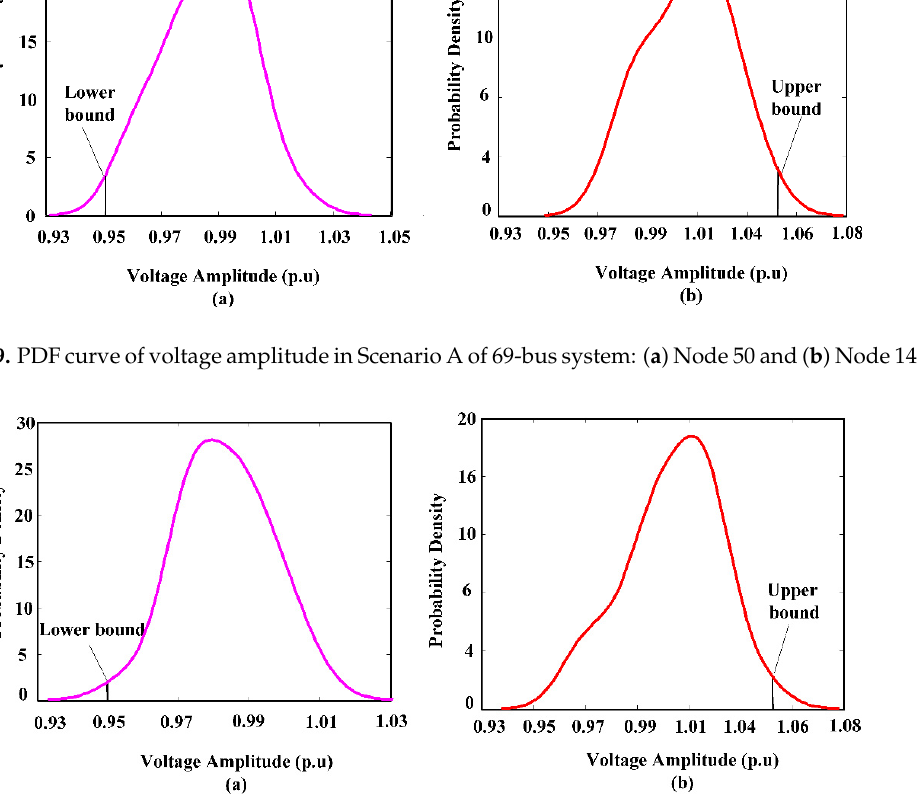
Figure 10. PDF curve of voltage amplitude in Scenario B of 69 ‐ bus system: ( a ) Node 50 and ( b ) Node 14.